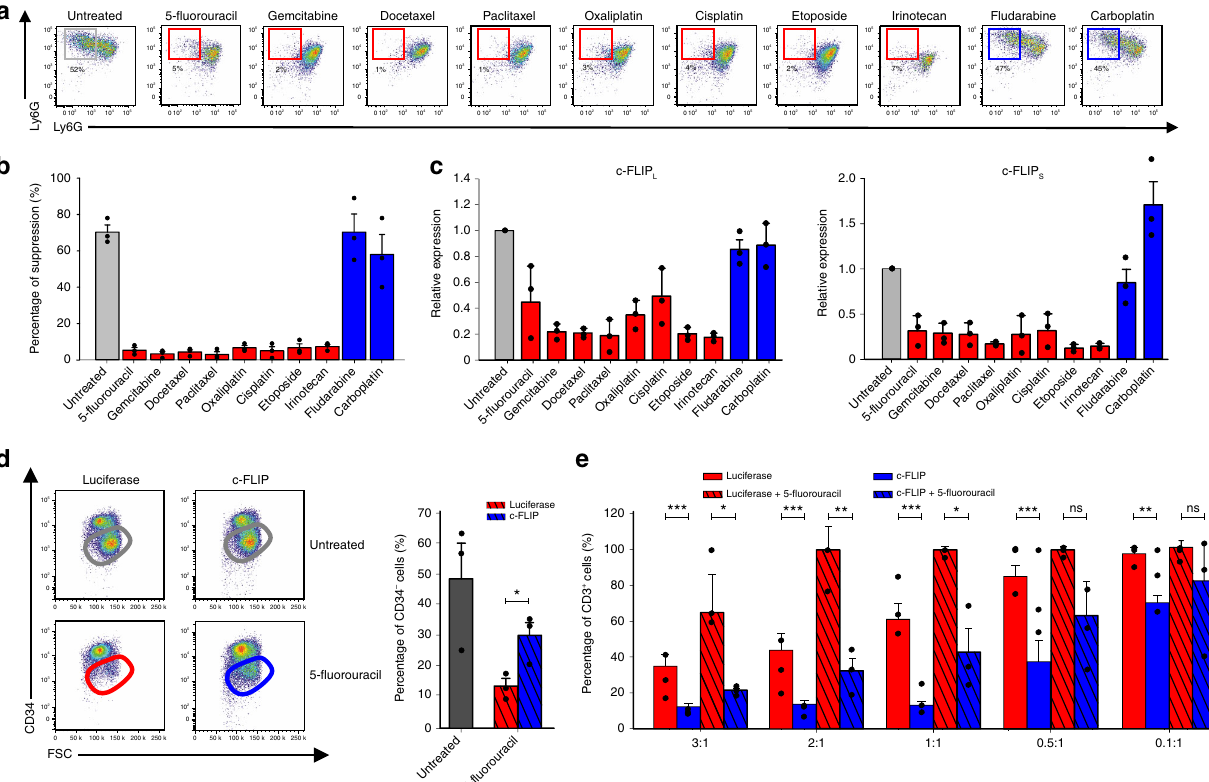
Fig. 1 c-FLIP protects in vitro generated M-MDSCs from chemotherapy-induced death. a Representative fl ow cytometry plots of mouse BM-MDSCs after chemotherapy treatment. Untreated Ly6C + cells are in black squares; in red and in blue, Ly6C + cells after exposure to the highest dose of chemotherapy that maintains the cell viability (de fi ned as ≥ 75% of AnnV - /7AAD - cells). b Suppressive activity of untreated (black bar) or chemotherapy-treated BM- MDSCs (red bars indicate M-MDSC-affecting chemotherapeutics whereas blue bars indicate ineffective chemotherapeutics) was measured by CellTrace dilution in peptide-activated CD8 + T cells. c Expression levels of both c-FLIP L and c-FLIP S in Ly6C + cells puri fi ed from BM-MDSCs treated with different chemotherapy were evaluated by real-time PCR. d Flow cytometry analysis of c-FLIP infected human in vitro generated BM-MDSCs (identi fi ed as CD34 - cells) after 5- fl uorouracil treatment. e Functional assay on luciferase- and c-FLIP-infected BM-MDSCs derived from in vitro differentiation of hCD34 + cells, either left untreated or after exposure to a M-MDSC-affecting dose of 5- fl uorouracil. Data are presented either as mean ± s.e.m of three independent experiments ( b – e ) or as a representative experiment of three independent experiments ( a ). * P < 0.05, ** P < 0.01; *** P < 0.001; n.s., not signi fi cant,